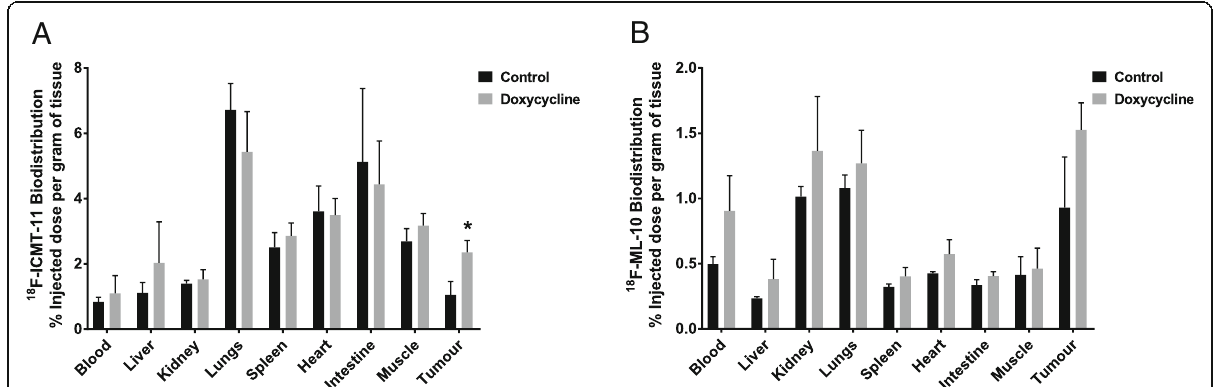
Fig. 4 In vivo biodistribution of apoptotic radiotracers in response to death-switch induction. a 18 F-ICMT-11 and b 18 F-ML-10. Biodistribution of the radiotracers was assessed in the B16ovaRevC3 tumour model, 24 h after vehicle-control or doxycycline administration ( n = 6 mice per group). Radioactivity in select tissues was measured by ex vivo gamma counting and biodistribution was calculated as percentage of injected dose per gram of tissue (%injected dose/g). Tumour uptake of 18 F-ICMT-11 was significantly higher after doxycycline administration (caspase-3 activation) compared with controls (* p < 0.01, Student ’ s t test; p = 0.02, two-way ANOVA); however, no significant difference was observed with 18 F-ML-10. There were no significant differences in the tissue distribution of both radiotracers between control and doxycycline-treated